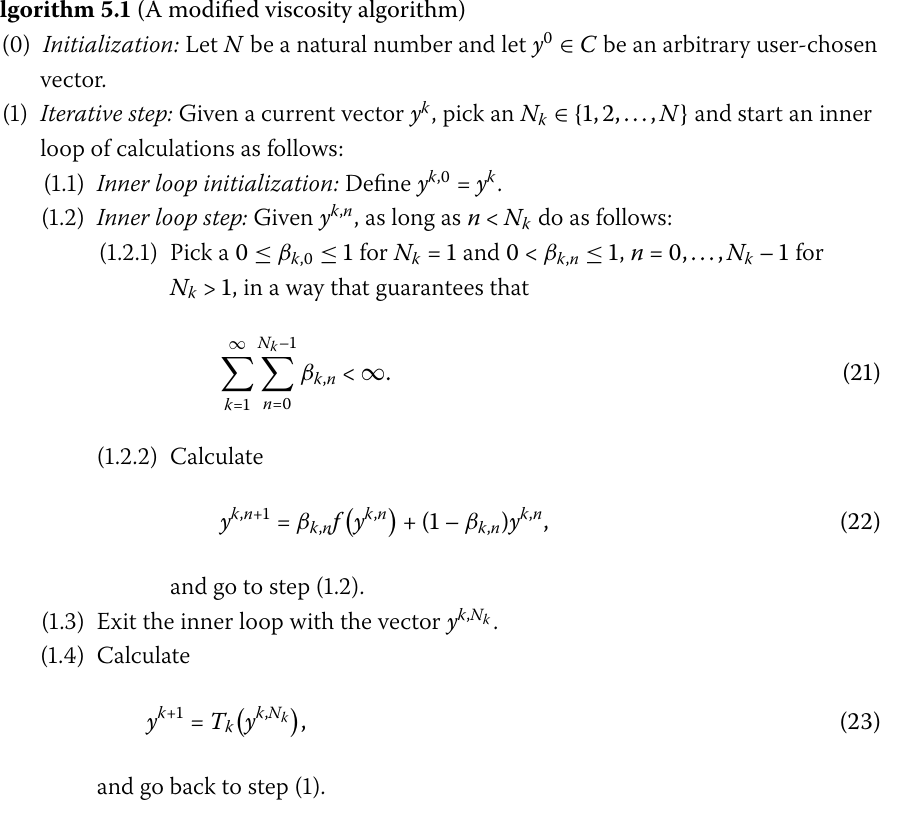
Algorithm . (A modified viscosity